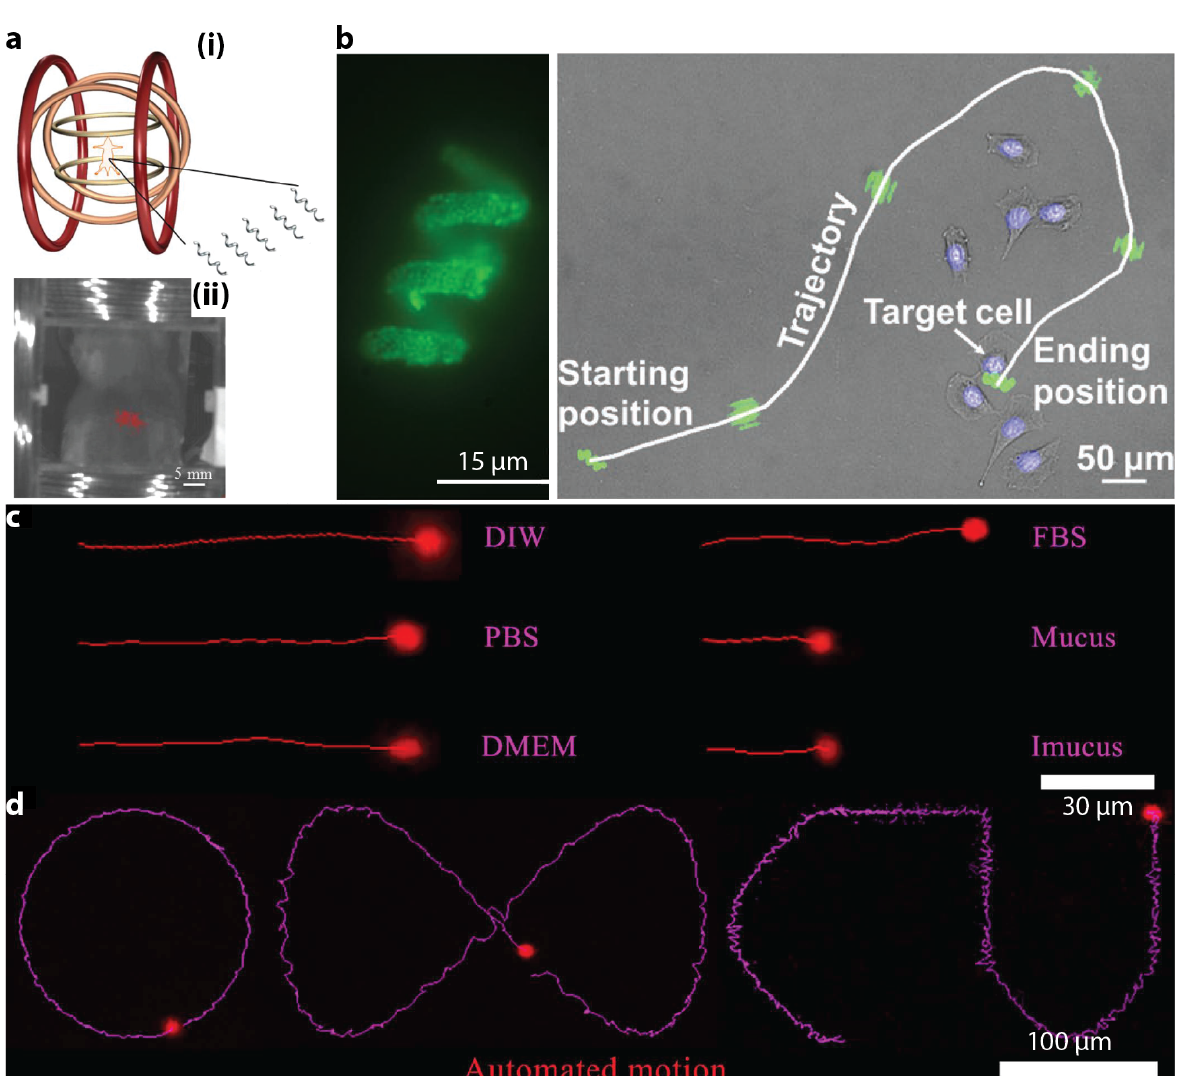
Figure 6. Exemplar studies of small-scale magnetic robotic systems with fluorescence imaging. ( a ) Fluorescence imaging of the swimming of a swarm of f-ABFs in vivo. Reproduced with permission from [96]. Copyright © 2015 WILEY-VCH Verlag GmbH & Co. KGaA, Weinheim. ( b ) A small-scale helical swimmer was observed using fluorescence imaging. Microscopy image shows the movement of a swimmer along a trajectory to target at a single cell. Reproduced with permission from [98]. Copyright © 2019 WILEY-VCH Verlag GmbH & Co. KGaA, Weinheim. ( c ) Fluorescence motion trajectories of the microrobots in DIW, PBS, DMEM, FBS, mucus, and intestinal mucus (Imucus) in a rotating magnetic field within 6 seconds (10 mT at 4 Hz). Reproduced with permission from AAAS [99]. ( d ) Fluorescence trajectories of the autonomous navigation of the microrobots in DIW according to predefined paths. Reproduced with permission from AAAS